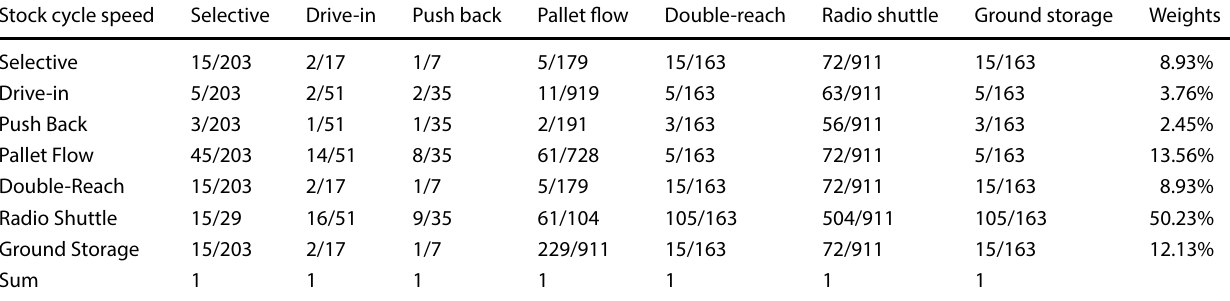
Table 15 Normalized matrix for the stock cycle speed criterion Stock cycle